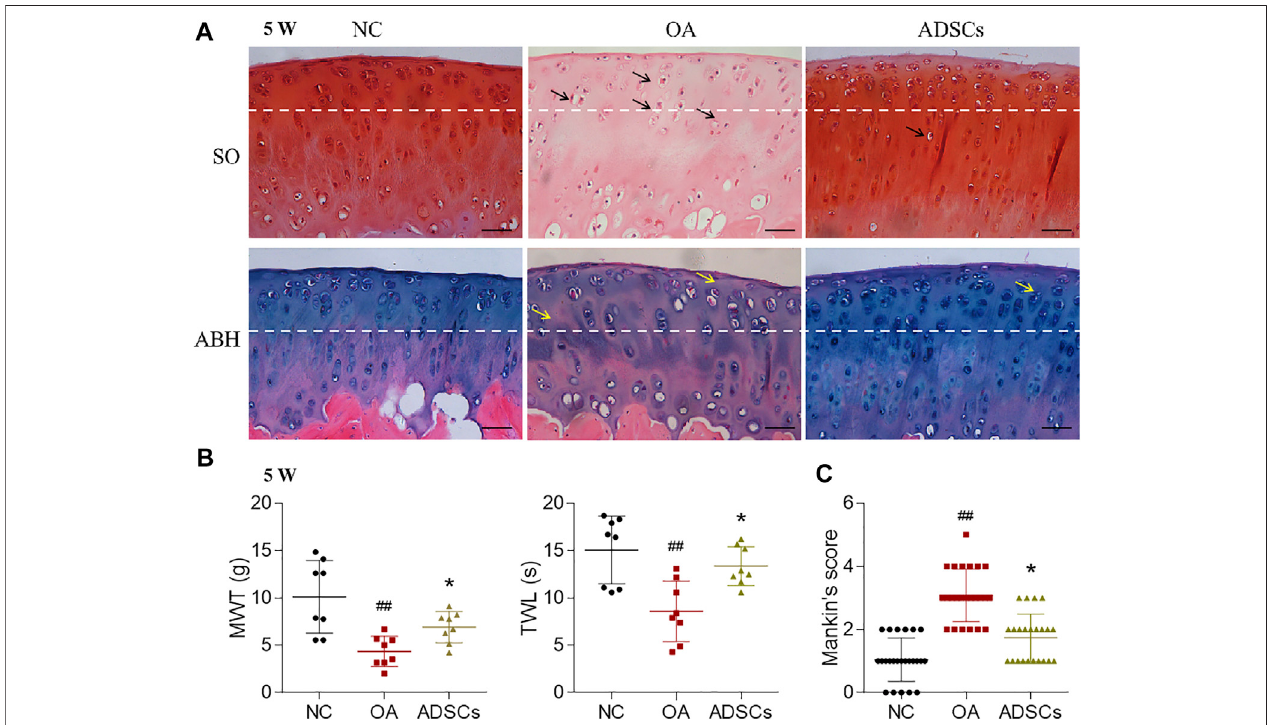
FIGURE 2 | Effects of ADSCs on MIA-induced rat OA model. (A) Safranin O/Fast green (SO) staining and alcian blue hematoxylin (ABH) staining with black arrows (chondrocyte loss, collagen disruption) and yellow arrows (chondrocyte loss, matrix disorganization). The tissue was harvested at the fourth week after OA induction, which was the fi fth week of the total experiment (5 W). The white dash line indicates the border between cartilage and subchondral bone. Scale bars = 50 μ m. (B) Measurement of MWT and TWL of rats. N = 8. (C) Mankin ’ s scores for histopathological observation. Values were presented as mean ± SD. N = 24. ## p < 0.01 versus NC group; * p < 0.05 versus model